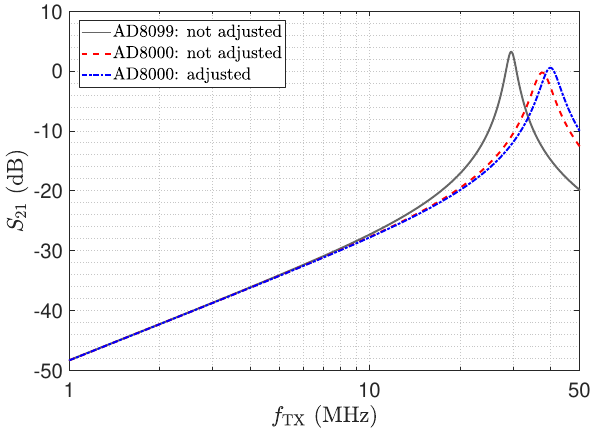
Figure 22. Transfer function of the matched LCR circuit determined by a SPICE simulation obtained for a direct attached assembly, as discussed in Section 2. The simulations were performed for two different operational